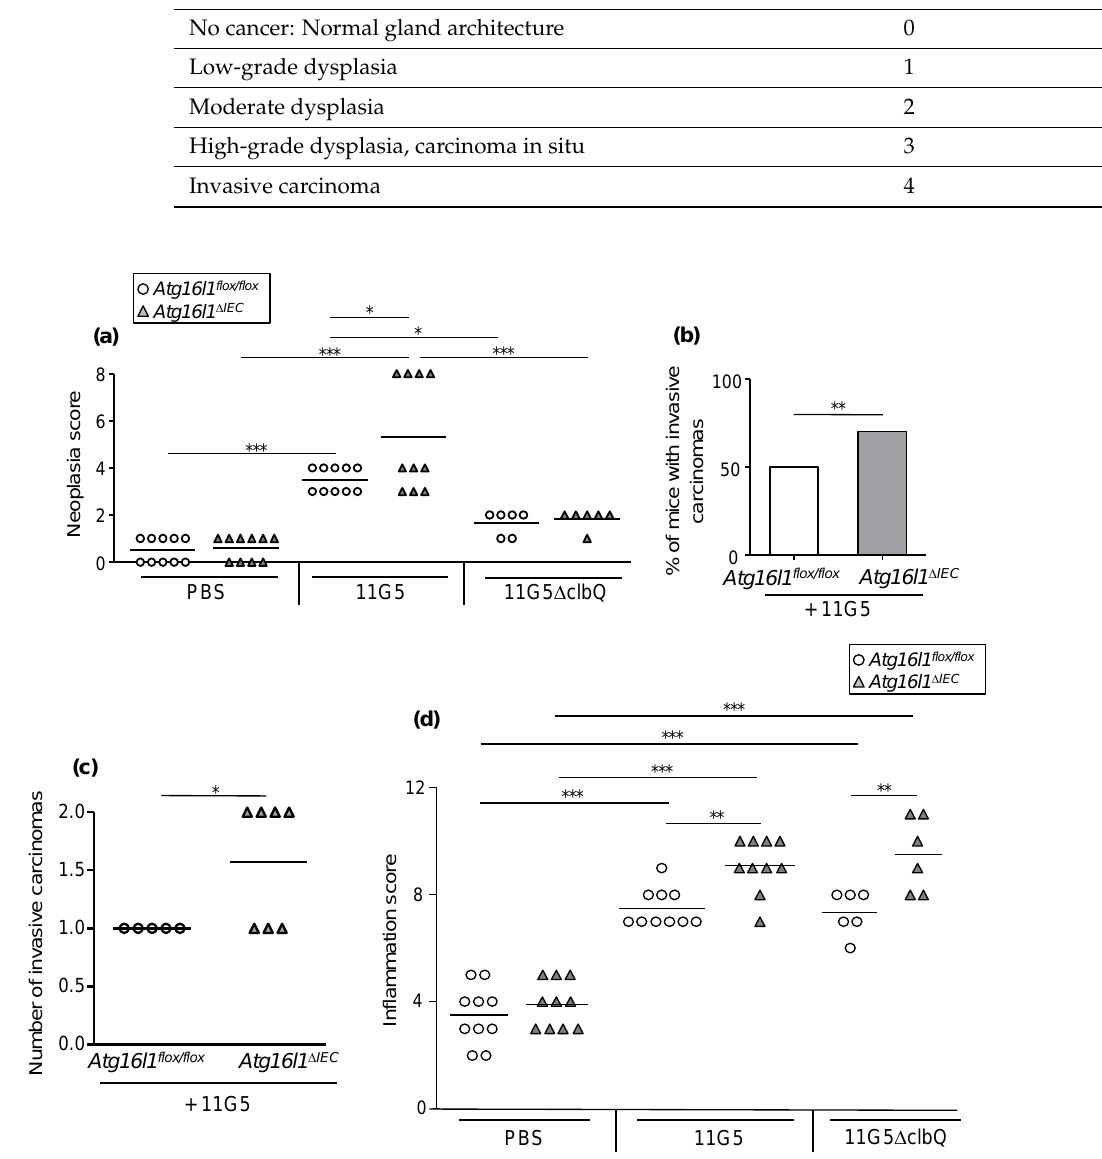
Figure 4. CoPEC infection induces colon tumorigenesis in a mouse model of CRC, independently of inflammation, and this was further enhanced by intestinal autophagy deficiency. Atg16l1 flox/flox and Atg16l1 ∆IEC mice were treated with streptomycin for 3 days and then received water for 24 h before being orally administered (day 0) with PBS or with 10 9 colony-forming units of 11G5 bacteria or the mutant 11G5∆clbQ. Neoplasia score ( a ), percentage of mice with invasive adenocarcinomas ( b ), number of invasive carcinomas ( c ) and inflammation score ( d ) were determined based on the histological evaluation of the colonic sections under blinded conditions by an expert pathologist. * p < 0.05; ** p ≤ 0.01; *** p ≤ 0.001 by one-way Anova, followed by a post-test Bonferroni in ( a , d ), the Fisher exact test in ( b ), and two-way t test in ( c ). ( a , c , d ) Each symbol represents data from one mouse, lines at mean. ( a , b , d ) N = 10 mice/group for +PBS and 11G5-infected conditions, and N = 6 mice/group for 11G5∆clbQ-infected condition. ( c ) Atg16l1 flox/flox + 11G5: N = 5; Atg16l1 ∆IEC + 11G5: N = 7.